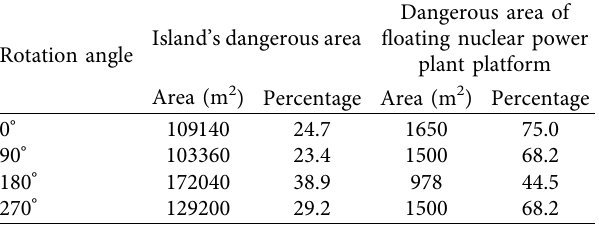
Table 4: The dangerous area and proportion after rotating at the southern break.